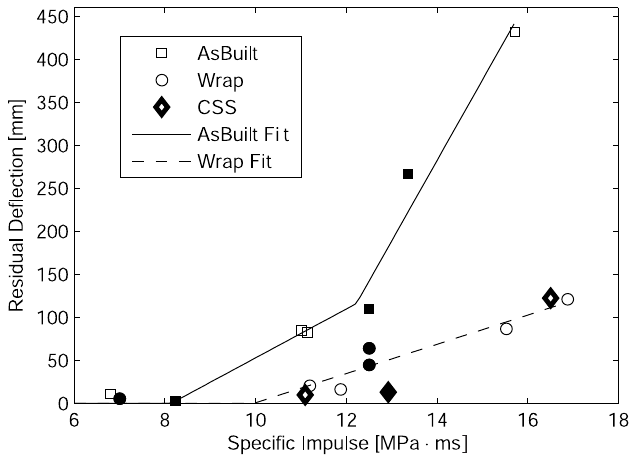
Fig. 8. Demand-damage data for column tests. Field tests are indicated with fi lled symbols and laboratory tests with hollow